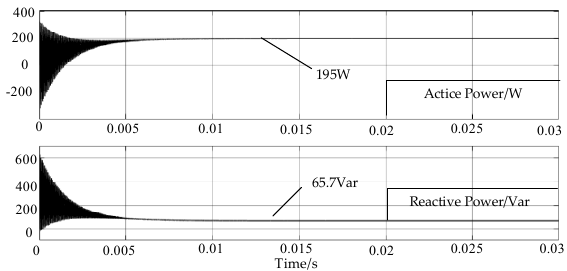
Figure 14. φ AD = 30°, φ AB = 76.9° active power and reactive power waveforms. Figure 14. ϕ AD = 30 ◦ , ϕ AB = 76.9 ◦ active power and reactive power waveforms.